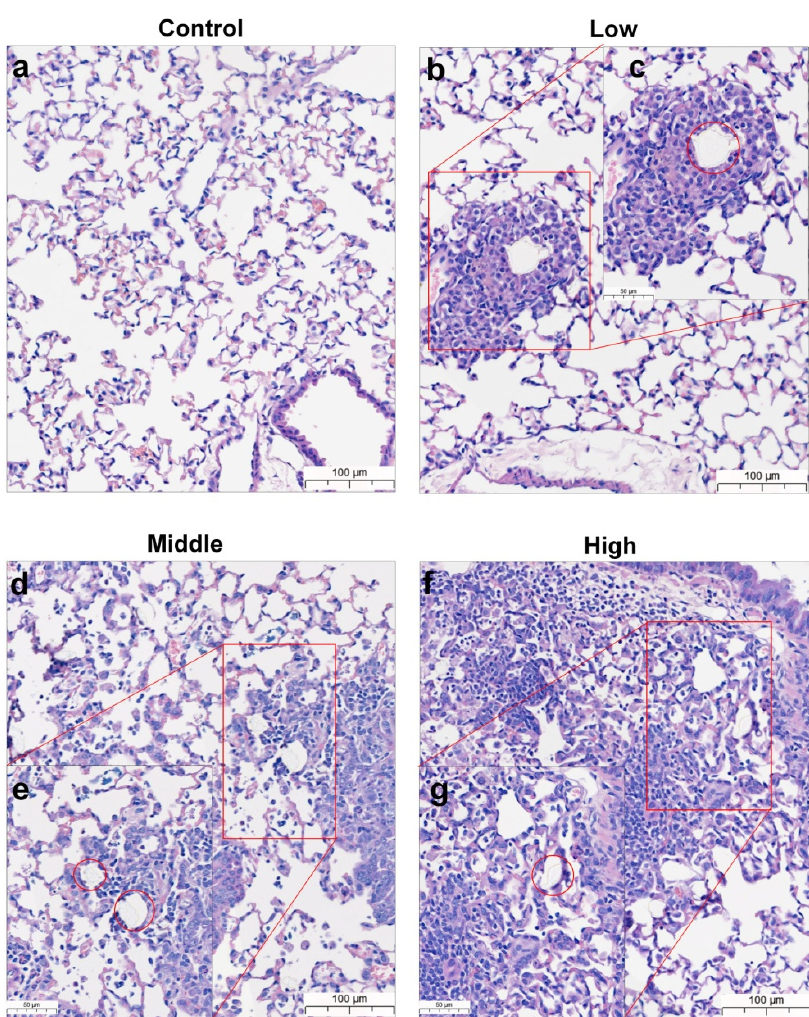
Figure 5. Lung histopathological evaluation of mice from the 28-day repeated oral dose toxicity study. Lungs of female mice from ( a ) control group, ( b , c ) low-dose group, ( d , e ) mid-dose group, and ( f , g ) high-dose groups. Left picture represents low magnification, and right is magnified area of red box. Foreign bodies presumed to be polyethylene microplastics in alveolar space of lung (red circle). Scale bar = 100 μ m, 50 μ m. Table 1. Clinical pathology analysis in 28-day repeated oral dose toxicity study. Male and female serum biochemistry results and male and female hematology data. Results are expressed as mean ±